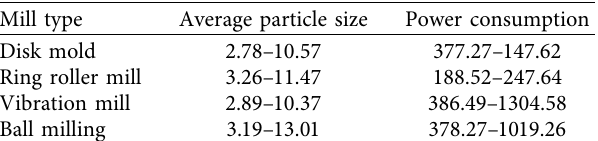
Table 3: Power consumption required for different particle sizes of ground fly